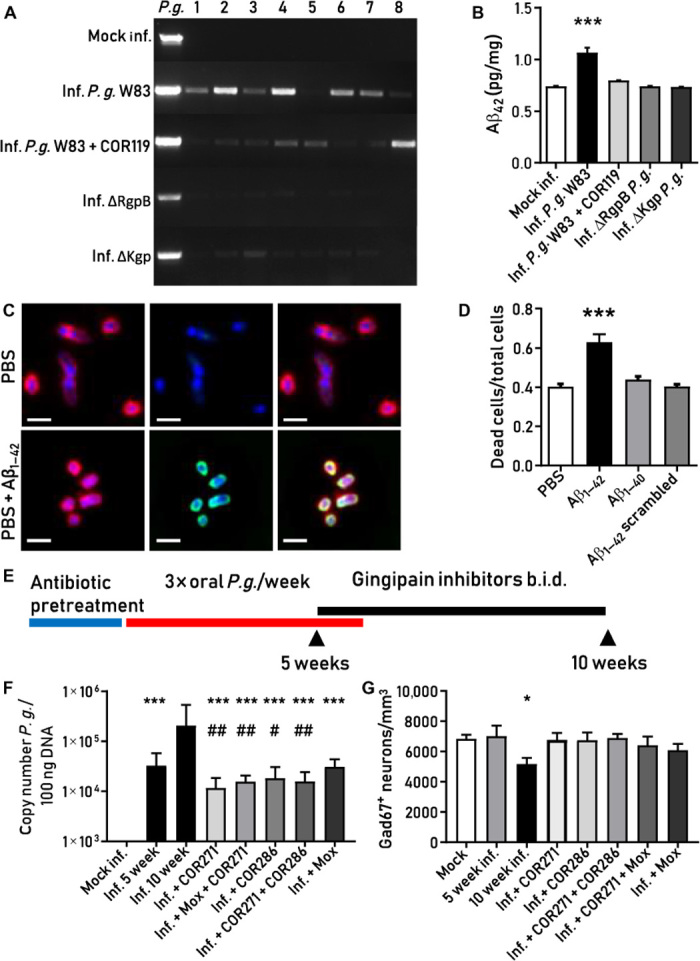
P. gingivalis invasion of the brain induces an Aβ1–42 response that is blocked by gingipain inhibition in mice.(A) P. gingivalis PCR product in mouse brains after oral infection with P. gingivalis W83, with or without treatment with the Kgp inhibitor COR119, or infection with gingipain knockout strain ΔRgpB or ΔKgp. Lanes 1 to 8 represent individual experimental animals. In the first lane (P.g.), P. gingivalis W83 was used as a positive control. (B) P. gingivalis W83–infected mice, but not COR119-treated mice or mice infected with gingipain knockouts, had significantly higher Aβ1–42 levels compared to mock-infected mice (***P < 0.001, n = 40). (C) RgpB-IR (red) colocalized with Aβ1–42-IR (green) on the surface of P. gingivalis (D) Aβ1–42, but not Aβ1–40 or Aβ1–42 scrambled, decreased viability of P. gingivalis (***P < 0.001, n = 12). (E) Study design to quantitate the effect of gingipain inhibitors on brain P. gingivalis load. (F) qPCR results showed a substantial P. gingivalis copy number in the brain at 5 weeks, increasing 10-fold at 10 weeks (Inf. 10 week). All treatment groups showed a significant decrease in P. gingivalis load compared to vehicle-treated Inf. 10 week mice (***P < 0.0001, n = 63). Treatment with the Kgp inhibitor COR271 resulted in a 90% reduction of P. gingivalis copy number. Comparing treatment groups to baseline infection at the beginning of treatment (Inf. 5 week) showed a significant reduction with COR271 and COR286 (##P < 0.01, #P < 0.05) but not with moxifloxacin. (G) The number of Gad67+ interneurons in the dentate gyrus of the hippocampus was significantly decreased in the Inf. 10 week group (*P < 0.05, n = 120). This decrease was reduced in all treatment groups, with COR271 and COR286 trending to better protection than moxifloxacin. (F) Geometric mean with 95% confidence interval. (B), (D), and (G) show the mean with SEM error bars.